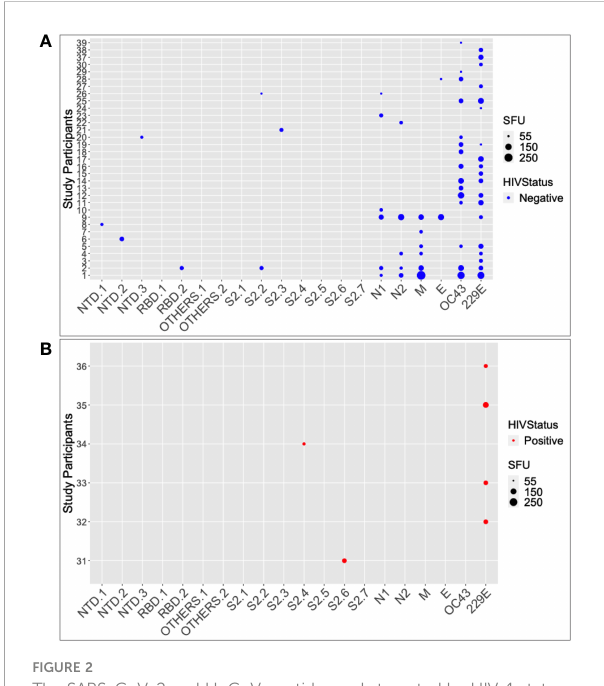
FIGURE 2 The SARS-CoV-2 and HuCoV peptide pools targeted by HIV-1 status. Summarizes the individual responses to each peptide pool for 39 of the participants who responded positively to at least one peptide pool. The data is strati fi ed by HIV serostatus, with HIV negatives in blue (A) and HIV positives in red (B) . The larger the size of the circle, the greater the